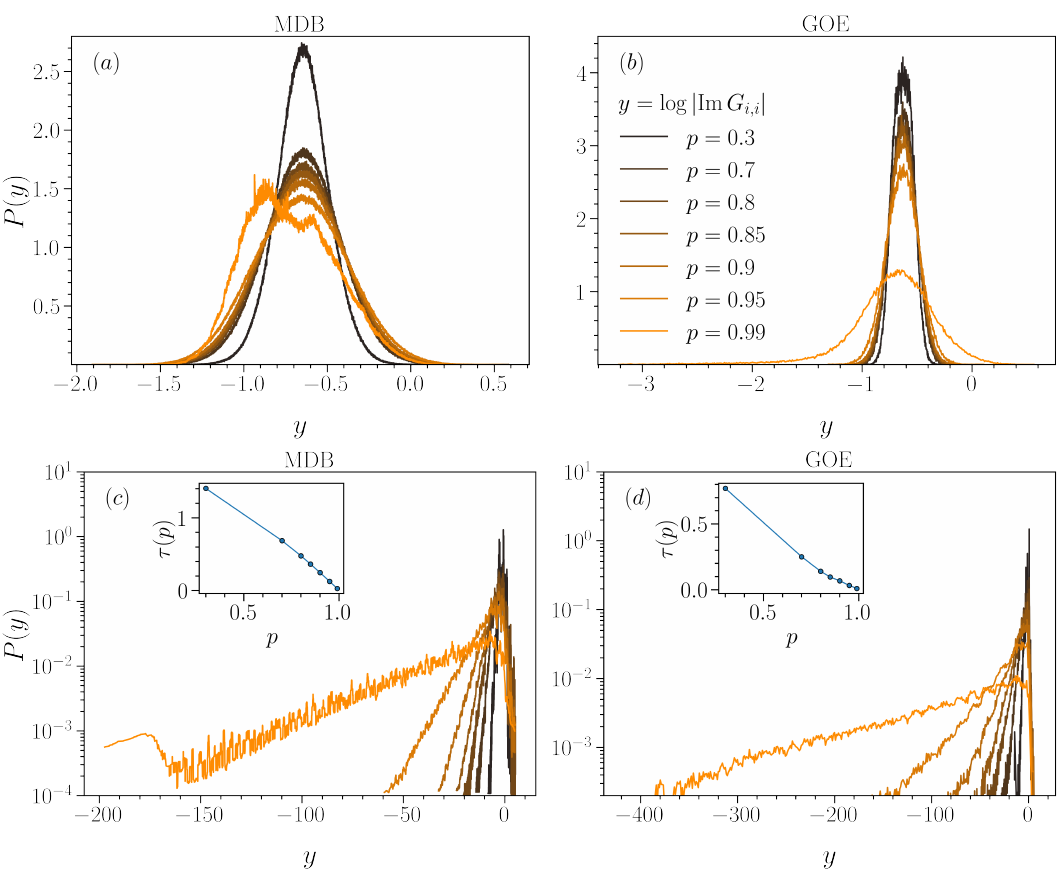
Figure 10: Histograms of the LDoS at ω = 0 for the AAH model with L = 512 at λ = 0.4 (a)-(b) and λ = 3 (c)-(d) for the random dephasing (top panels) and GOE (bottom panels). different values of λ and p . For λ < λ (panels (a) and (b)) we see that the histogram of c